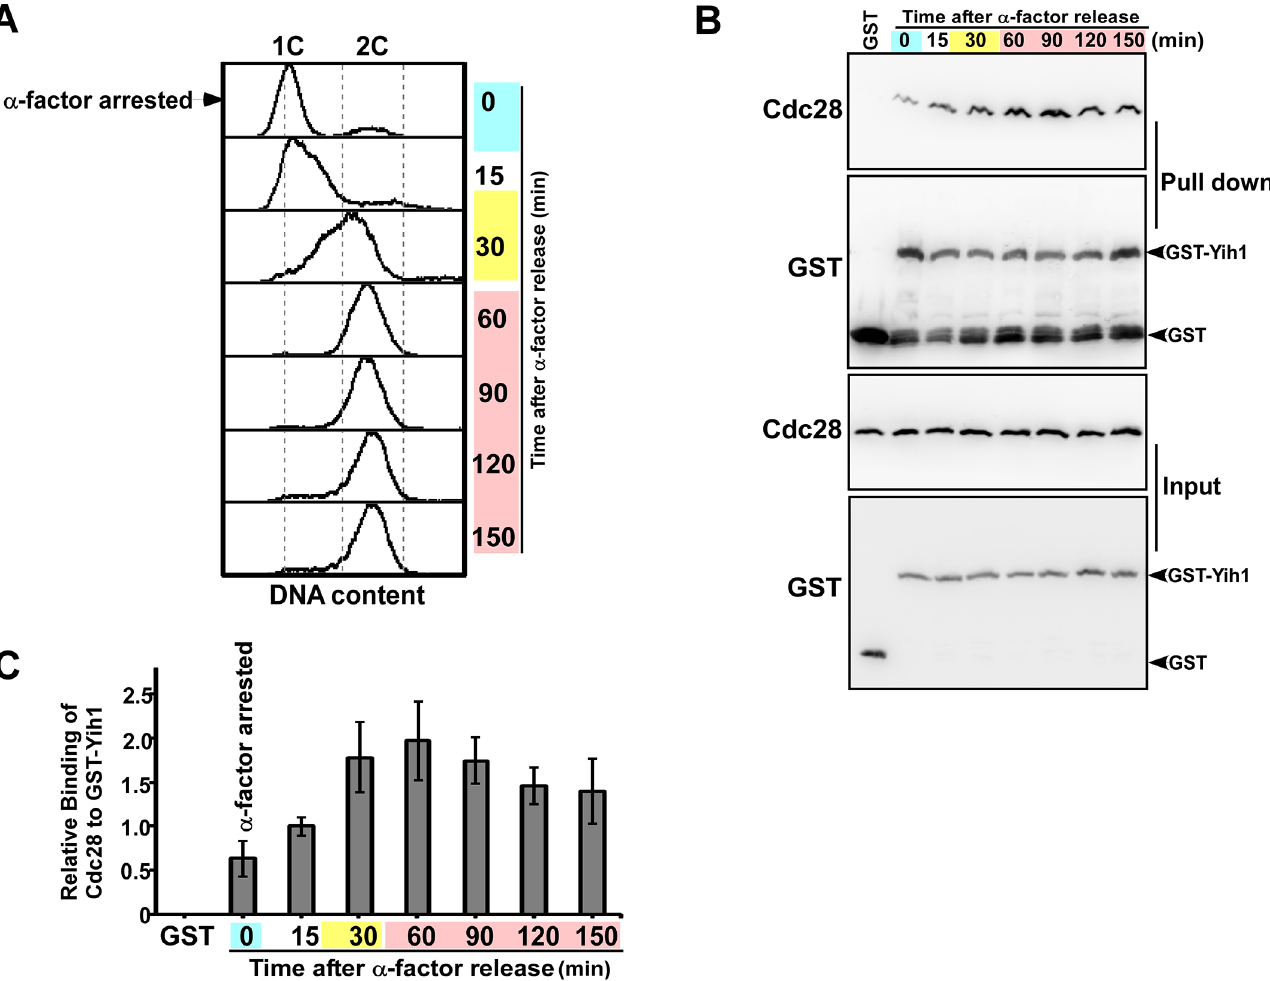
Fig 8. Evidence that GST-Yih1 preferentially binds to the Cdc28 active complex. yih1 Δ cells (MSY-Y2) expressing Yih1 fused to GST from a galactose- inducible promoter were grown to log-phase in S medium containing galactose as carbon source (SGal). Cells were synchronized with α -factor, released into fresh SD media and samples were collected at the indicated times. (A) Representative histograms of DNA content (PI staining) of arrested (G1 – time 0) and released cells measured by flow cytometry. The distribution of cells in G1 (1C), S and G2/M (2C), analyzed with the Flowjo software, 9.3.3 version is shown. (B) Representative immunoblot of in vivo GST-pull-down assays. The collected cells were promptly harvested and equal amounts of proteins (1 mg) were subjected to glutathione-mediated pull-down assays. All the precipitated material (upper-panels) and 2% of the input (lower-panels) were subjected to immunoblots to detect GST proteins and Cdc28. As a negative control, GST alone was expressed in asynchronous yih1 Δ cultures, pulled-down and analyzed as above. (C) The relative amount of Cdc28 bound to GST-Yih1 was determined with data from B using the NIH image J software. The amount of precipitated Cdc28 was normalized to the levels of precipitated GST-Yih1. Blue, yellow and pink shaded boxes indicate the estimated G1, S and G2/M cell cycle stages, respectively. Data represent mean ± S.E. of three independent